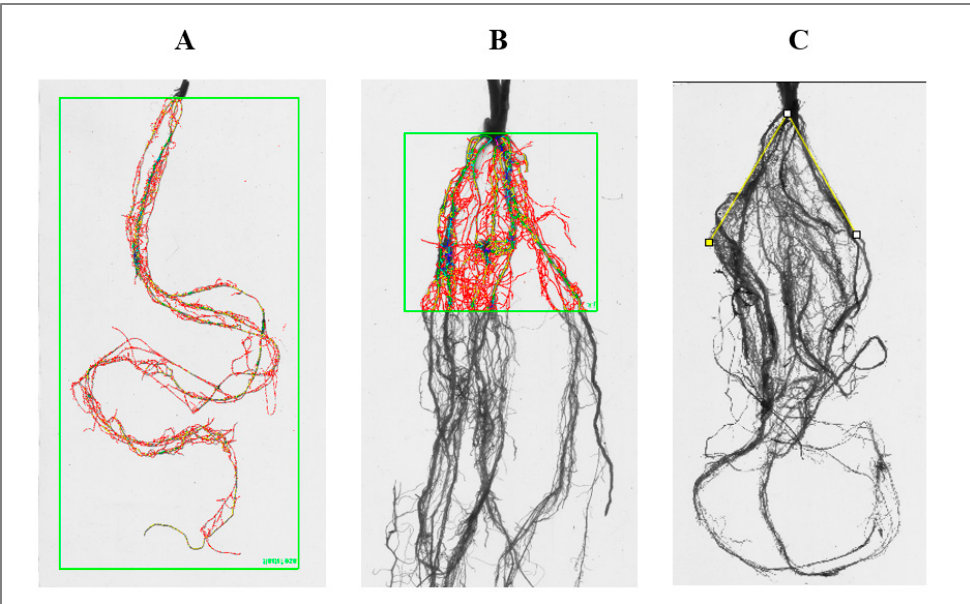
Figure 3. The measurements of morphological traits for whole roots ( A ), topsoil ( B ) using Win-RHIZO system, and root angle ( C ) using ImageJ (°).